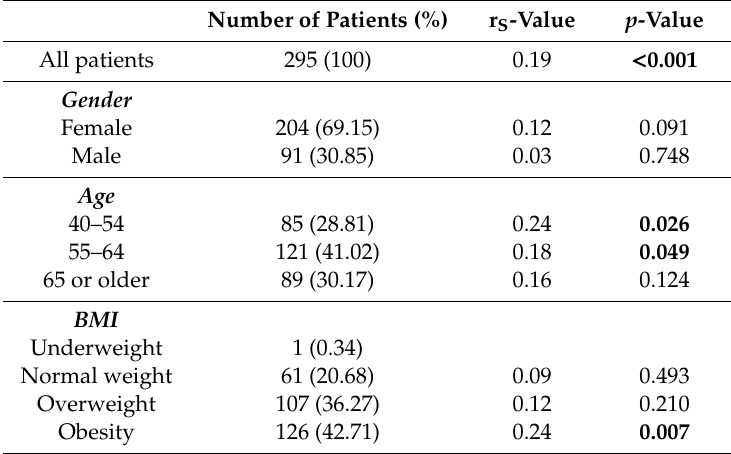
Table 3. Spearman’s correlation between reflection index and cardiovascular risk based on Heart Risk Calculator in groups divided by gender, age and body mass index. BMI = body mass index; p -value < 0.05 is indicated in bold.